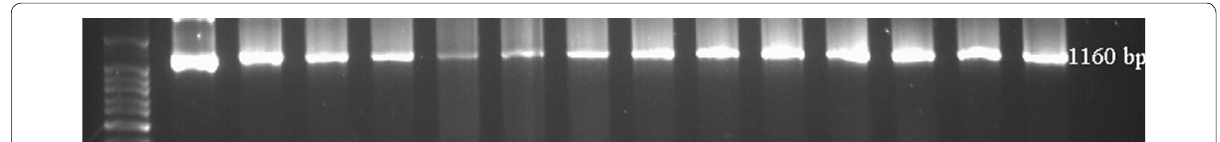
Fig. 1 PCR product of 1160 bp amplified with primers OI1/OI2 on 1.5% agarose gel of infected Kinnow with 100 bp marker